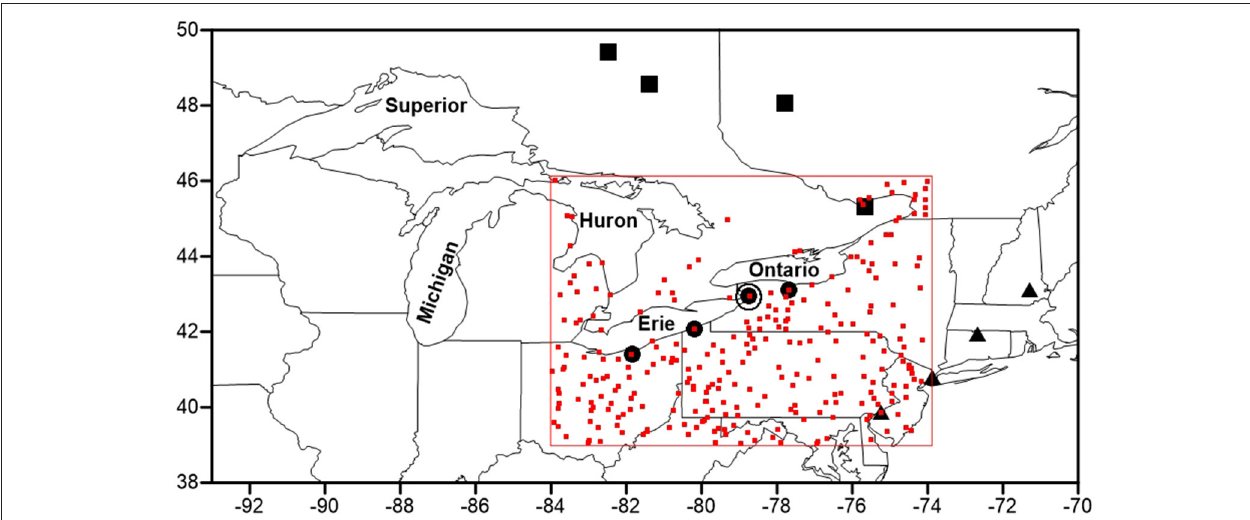
FIGURE 1 | The North American Great Lakes and the locations of GHCN-Daily precipitation stations (red squares within red boundary), the location of Buffalo, New York (large open circle) for which Suriano and Leathers (2017a) constructed a Temporal Synoptic Index, and the three sets of four locations for which Spatial Synoptic Classification data were applied by Ellis et al. (2021), with black-filled circles representing lake-effect stations, and black-filled squares and triangles representing northern and eastern non-lake-effect